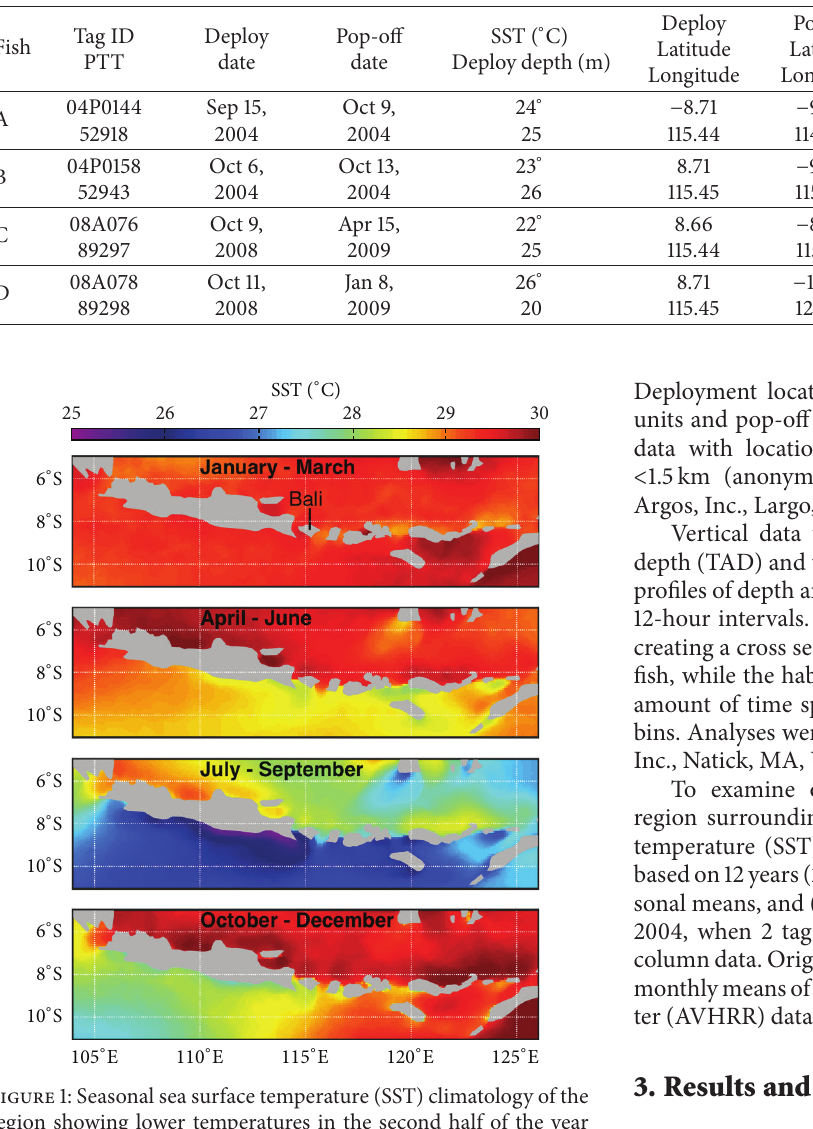
Table 1: Tag deployment summary. ∗ Straight line distance between deployment and pop-off locations. PTT is platform terminal transmitter, LC is location code, TL is total length, and SST is sea surface temperature.